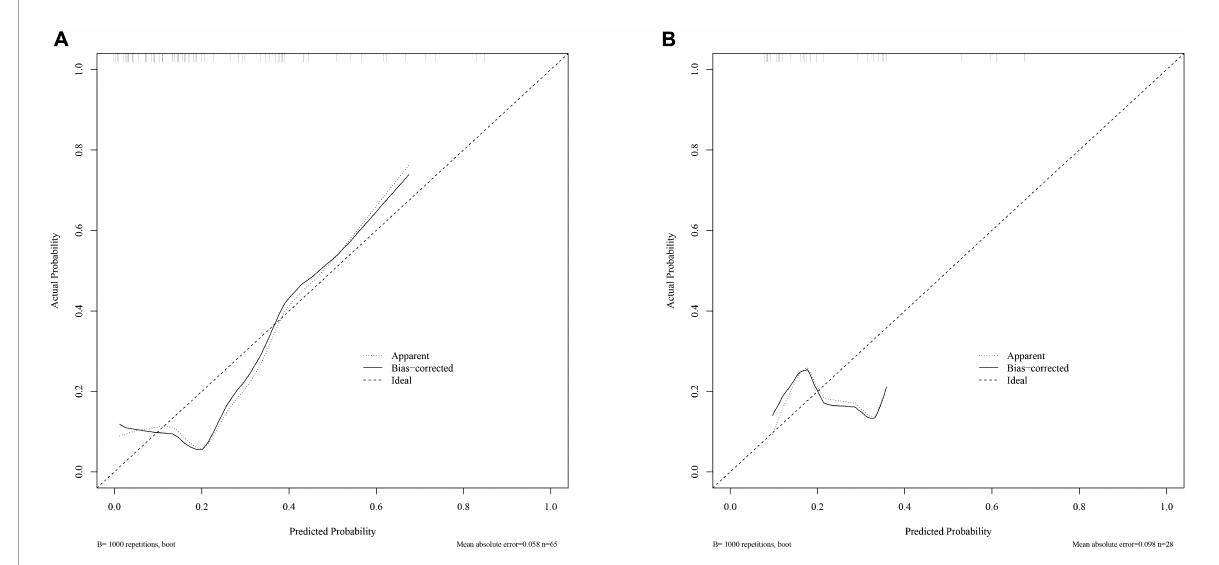
FIGURE5 Calibration curves of the radiomics signature in the training/validation cohort (A) and testing cohort (B) .